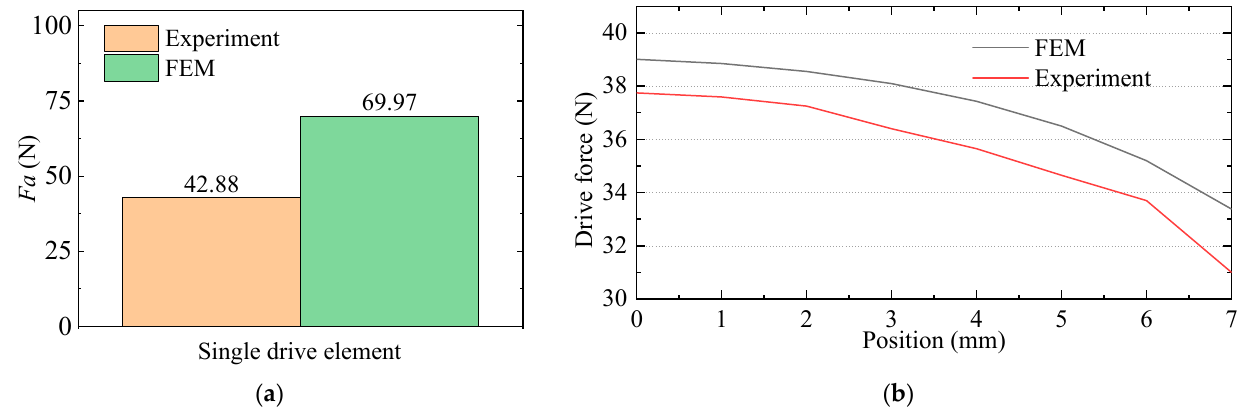
Figure 20. Electromagnetic force of the conveying platform: ( a ) attractive force and ( b ) driving force.